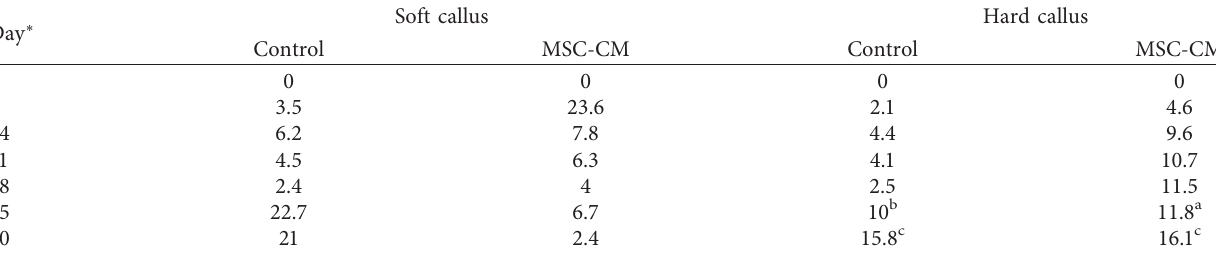
Table 1: Callus area measurement (mm 2